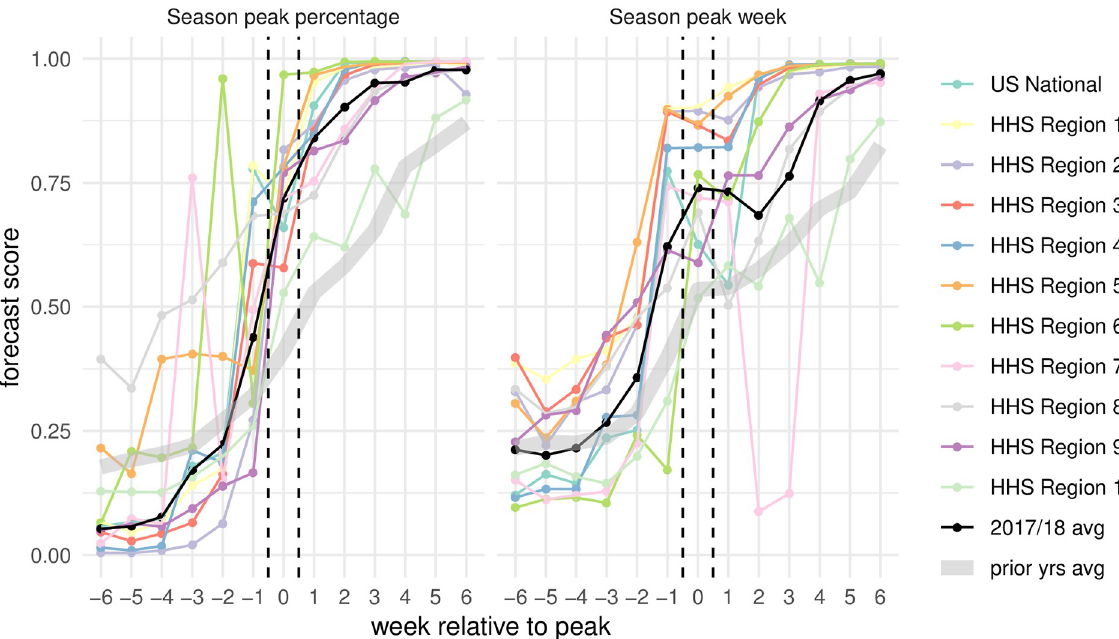
Fig 6. Forecast score for the FSNetwork-TTW model in 2017/2018 by week relative to peak. Scores for the two peak targets in each region were aligned to summarize performance relative to the peak week. On the x-axis, zero indicates the peak week and positive values represent weeks after the peak week. The black line indicates the overall geometric average across all regions. The grey band represents the geometric average across all regions and all seasons prior to 2017/2018.